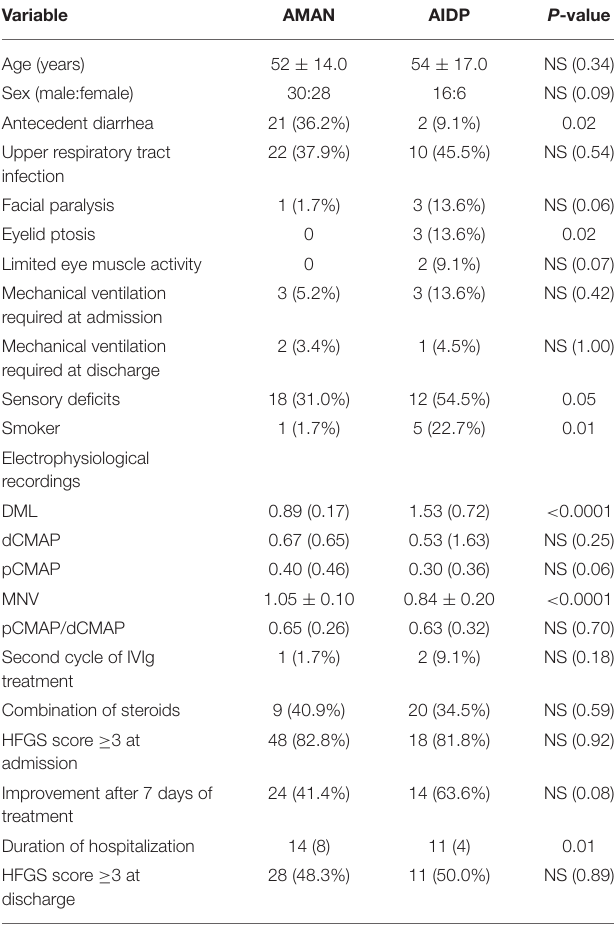
TABLE 1 | Partial clinical and electrophysiological characteristics of AIDP and AMAN subtype.